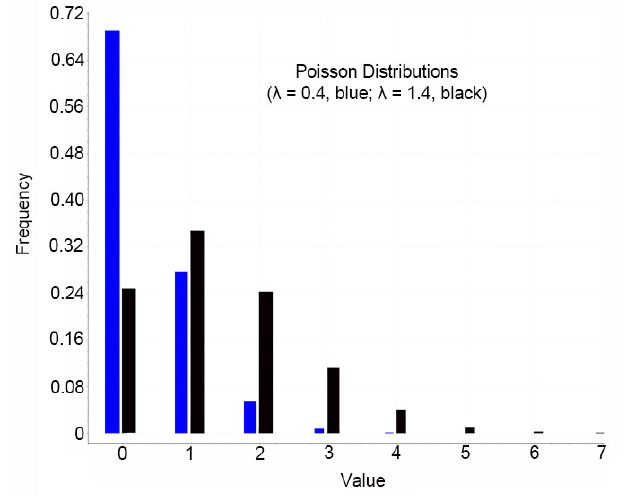
Fig. 2 . Lower and upper endpoint Poisson distributions used in modeling mortality at low-rise buildings that were ‘Least Likely’ to cause collision